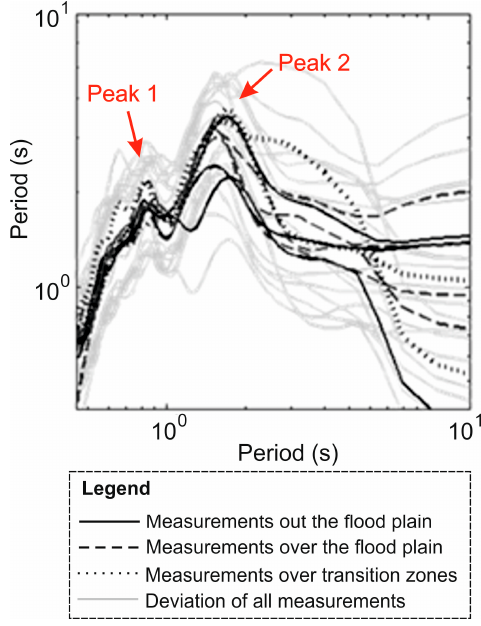
Figure 11. Passive seismic results (horizontal to vertical spectra ratio) in the zone affected by the subterranean stream in Mallorca Street. The arrows indicate the double-peak.